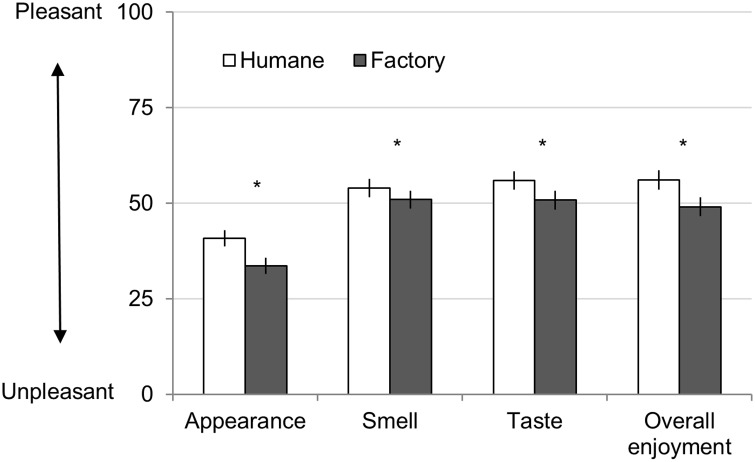
Study 1: Ratings of Beef Jerky Sample.Error bars represent standard errors, and asterisks represent significance (* p < 0.05). All ratings made on 100-point slider scale.